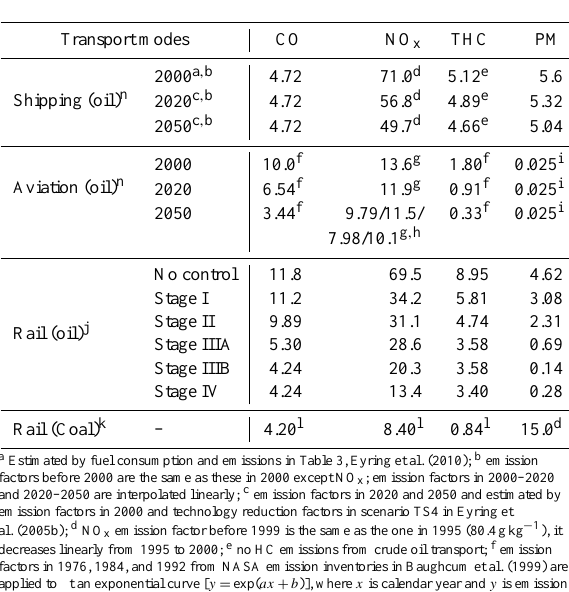
Table 5. Emission factors (unit: gkg − 1 ) for shipping, aviation, and